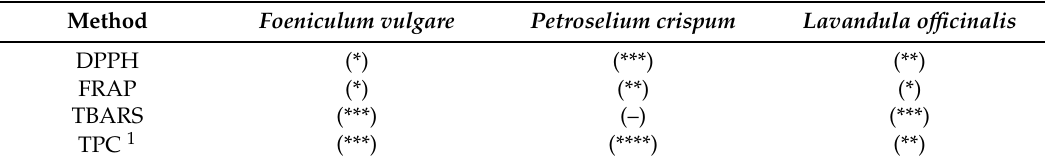
Table 6. Summary of antioxidant ability of organic fennel, parsley, and lavender essential oils from Spain as assessed by three antioxidant methods and